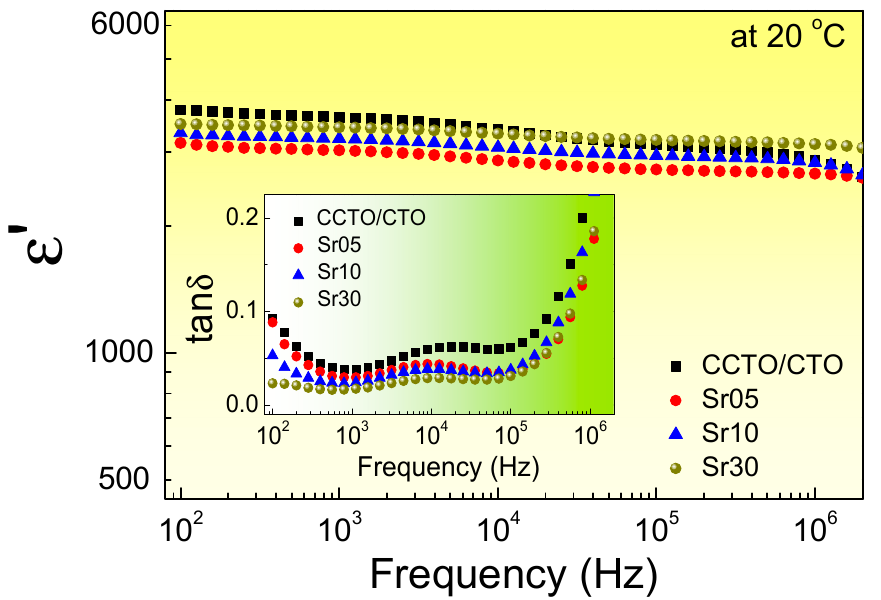
Figure 5. Frequency dependence of ε ′ at 20 °C for all composite samples. Inset shows tan δ as a function of frequency. The effects of Sr 2+ doping ions on the temperature dependence of the dielectric prop-